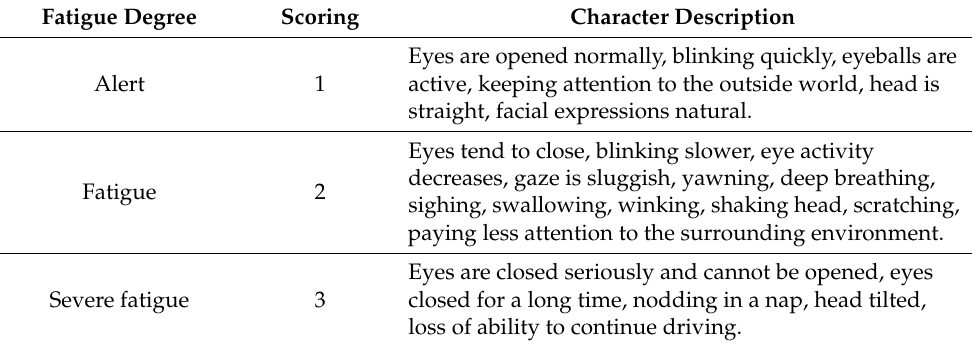
Table 1. Evaluation criteria of driver fatigue